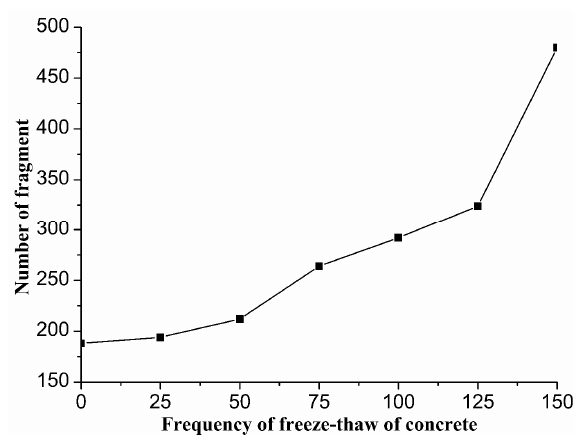
Figure 16. Number of fragments at the third stage point of freezing–thawing concrete.